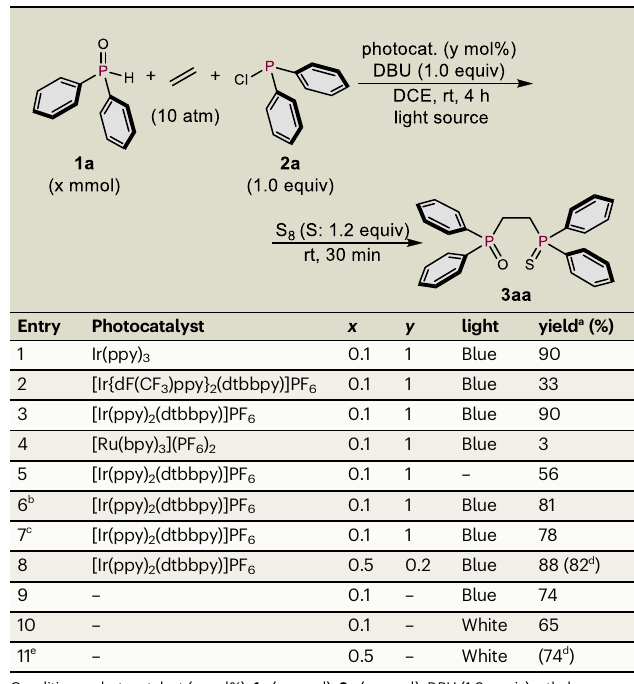
Table 1 | Optimizing the reaction conditions